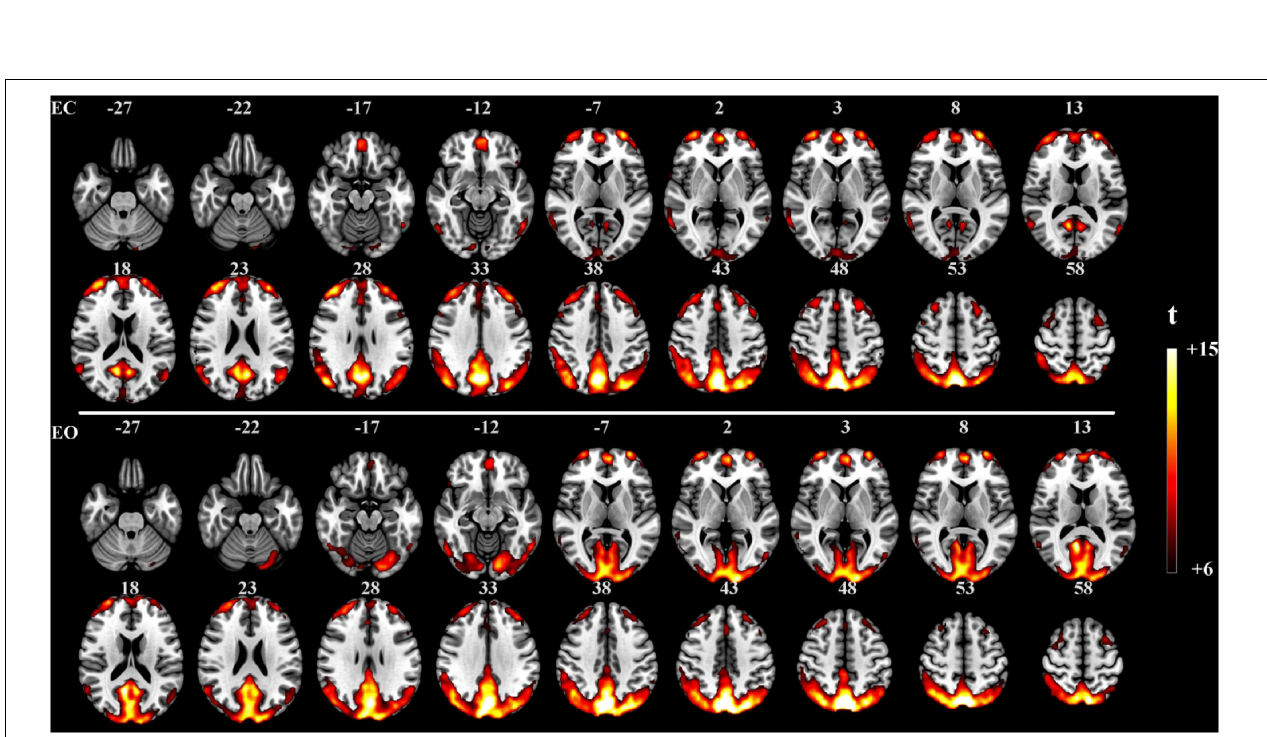
FIGURE 3 | One-sample t -test SCM maps under the EC ( n = 45, t > 6.0, p < 0.0005, FDR corrected) and EO ( n = 45, t > 6.0, p < 0.0005, FDR corrected) resting-state conditions.